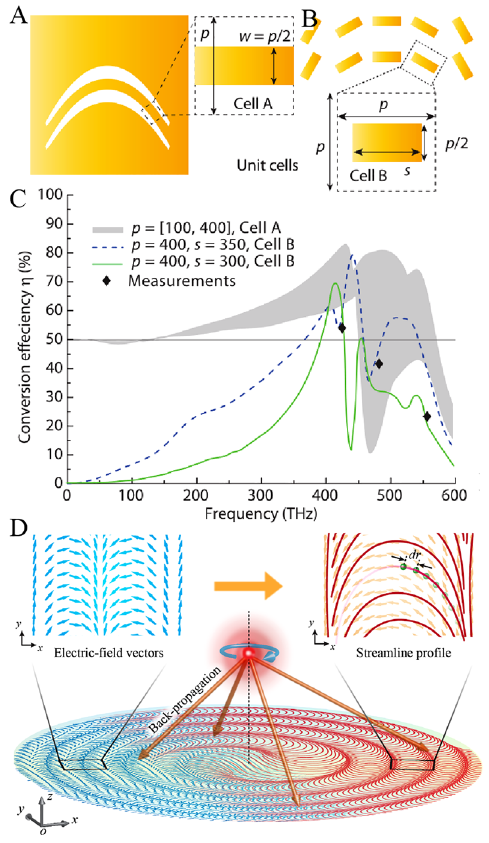
Figure 7: Comparison of the conversion efficiency between the catenary structure and discrete